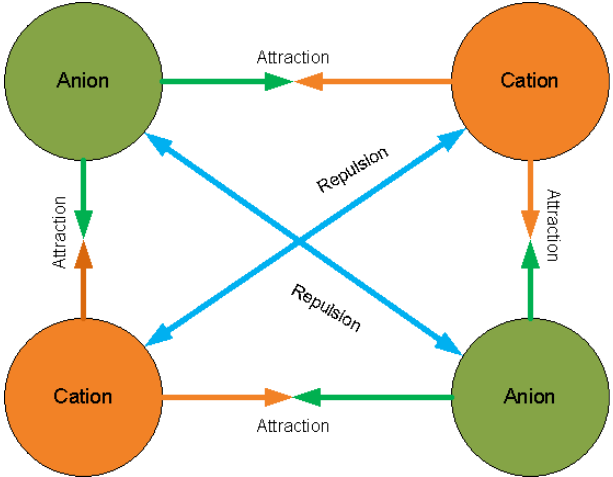
Fig. 1. Conceptual model of the force of attraction and